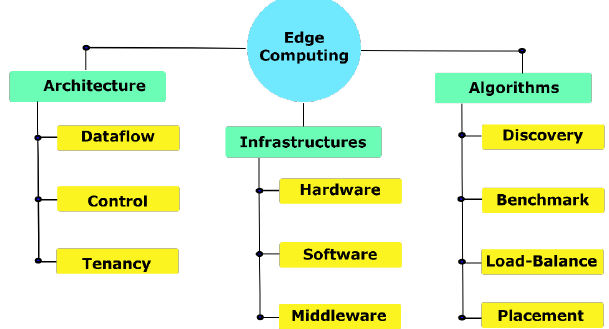
Figure 3. Edge computing resource